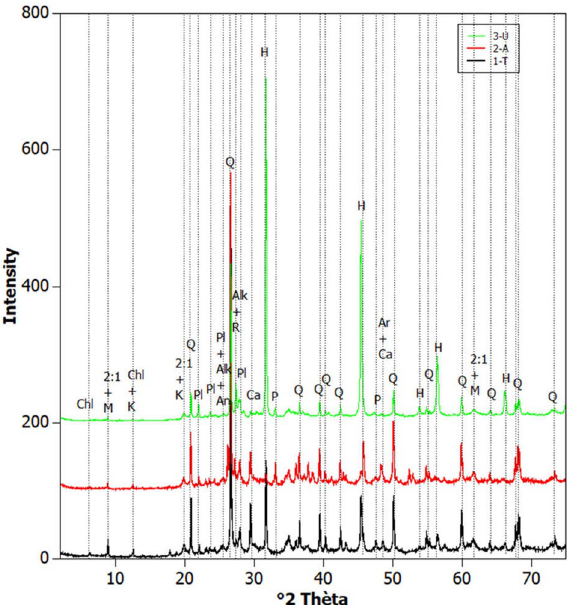
Figure 2. X-ray diffraction patterns on the raw mud samples (upper image) collected from the three lakes. The main minerals that contribute to the most important reflections are indicated. Chl: Chlorite, M: Muscovite, K: Kaolinite Group minerals, Q: Quartz, A: Anatase, 2:1: 2:1 phyllosilicate (e.g., illite and smectite), Ca: Calcite, Pl: Plagioclase/Albite/Andesine, R: Rutile, P: Pyrite, Ar: Aragonite, H: Halite.